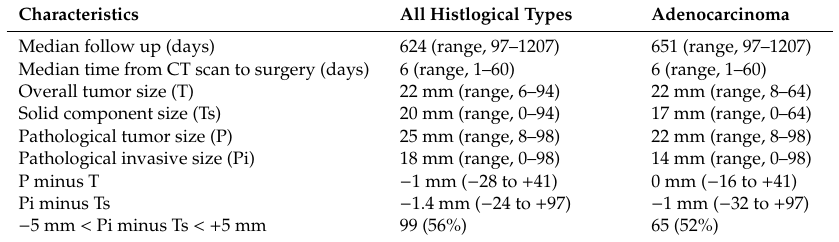
Table 6. Comparison of measurement diameter between adenocarcinoma and all histological types.